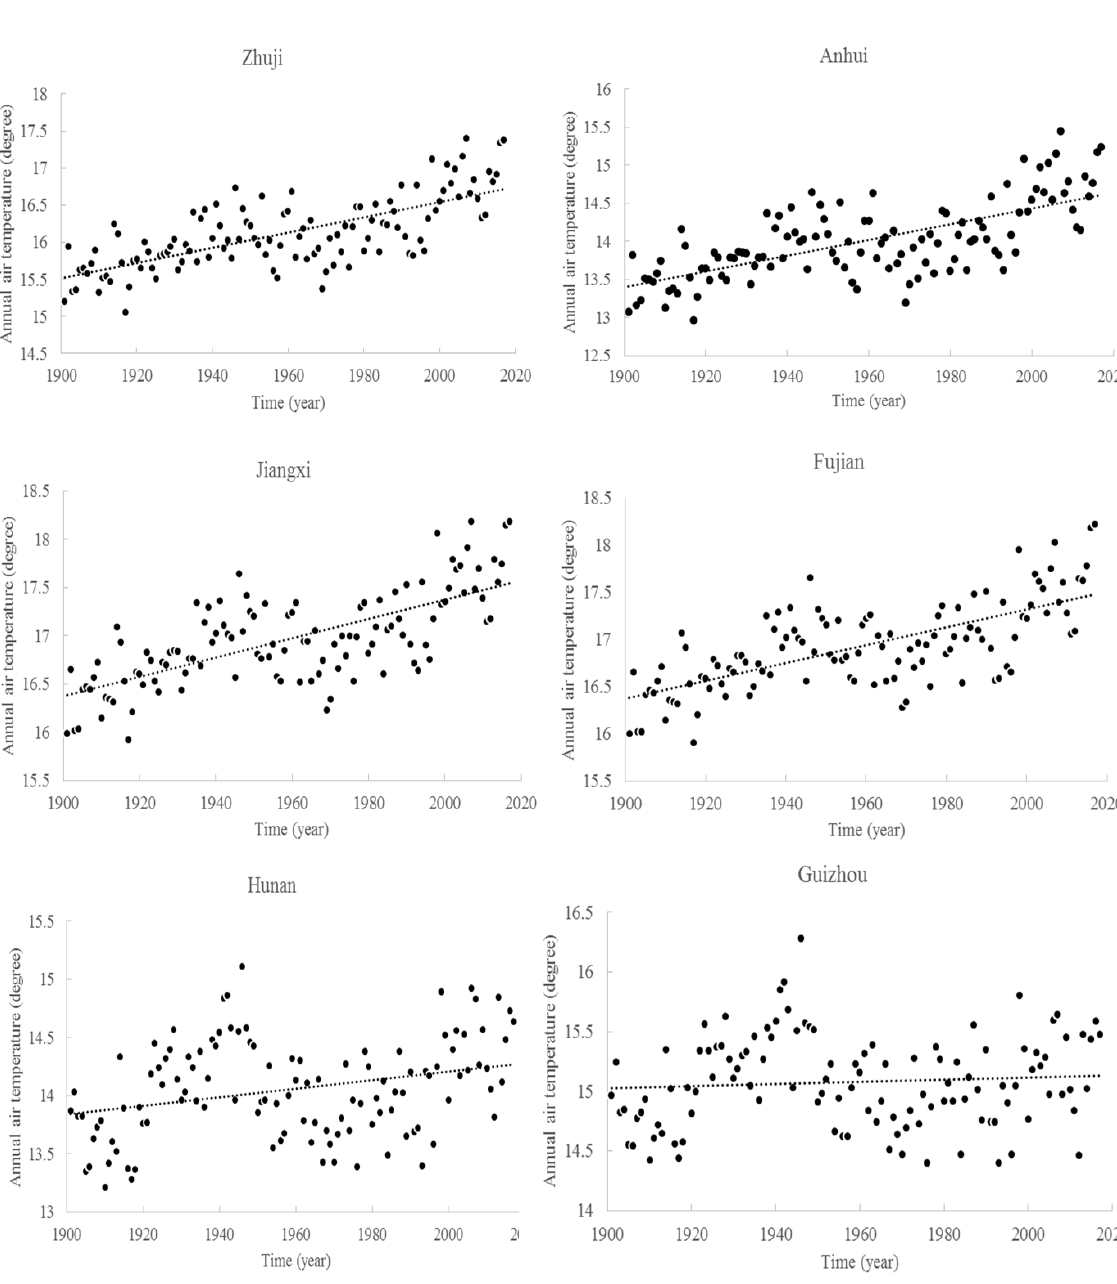
Figure 2. The general trend of annual air temperature in the six regions with Chinese Torreya plantations.